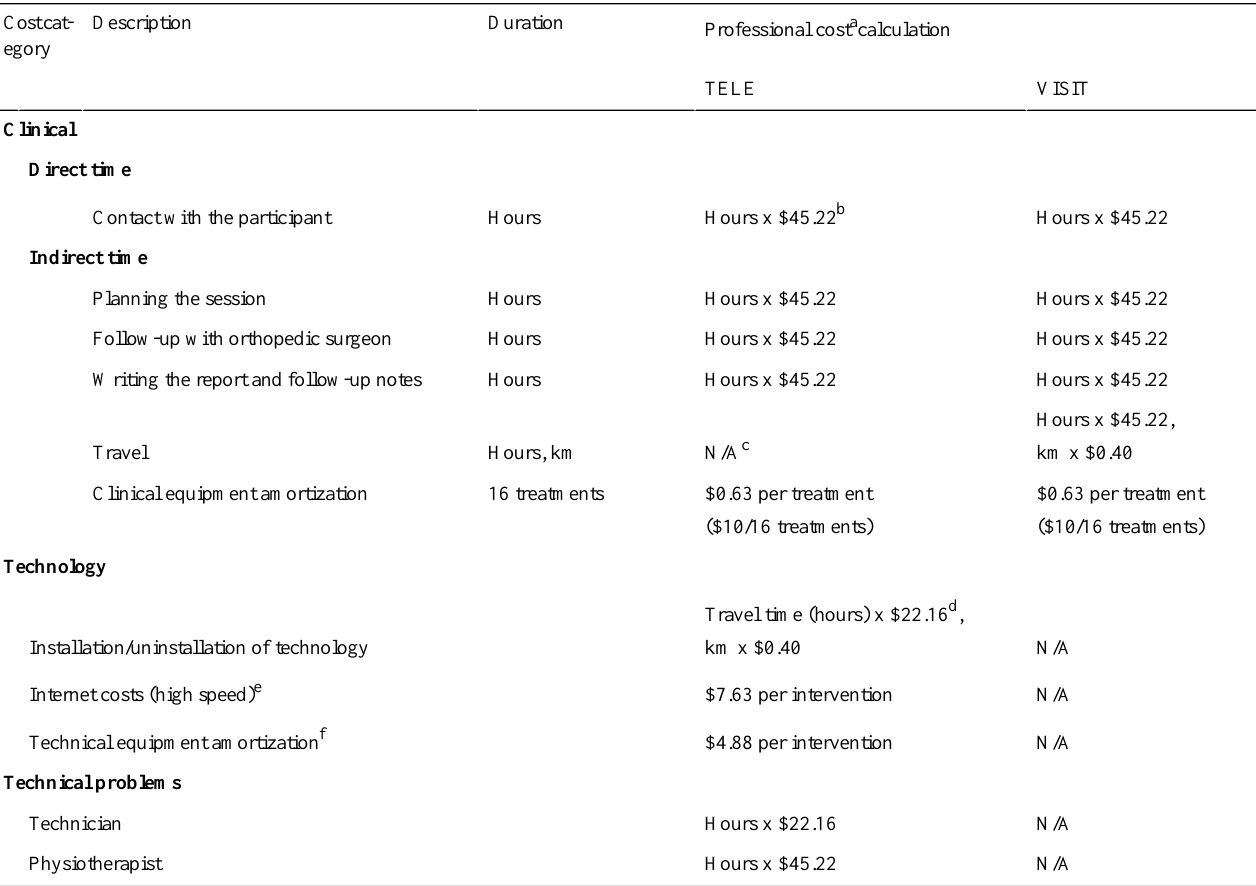
Table 1. Breakdown of costs per treatment for telerehabilitation and home